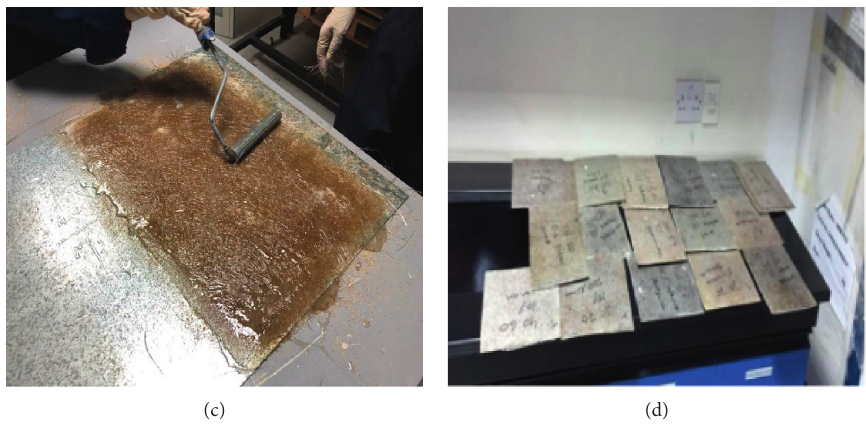
Figure 6: (a–c) Processing of composites by the hand lay technique; (d) composite laminates.